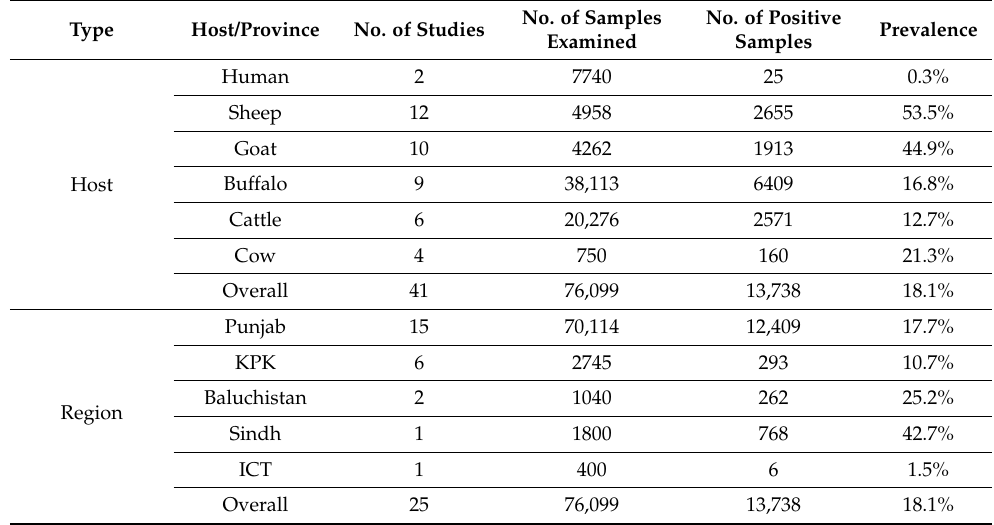
Table 2. Prevalence of fasciolosis according to host and geographical location in Pakistan.